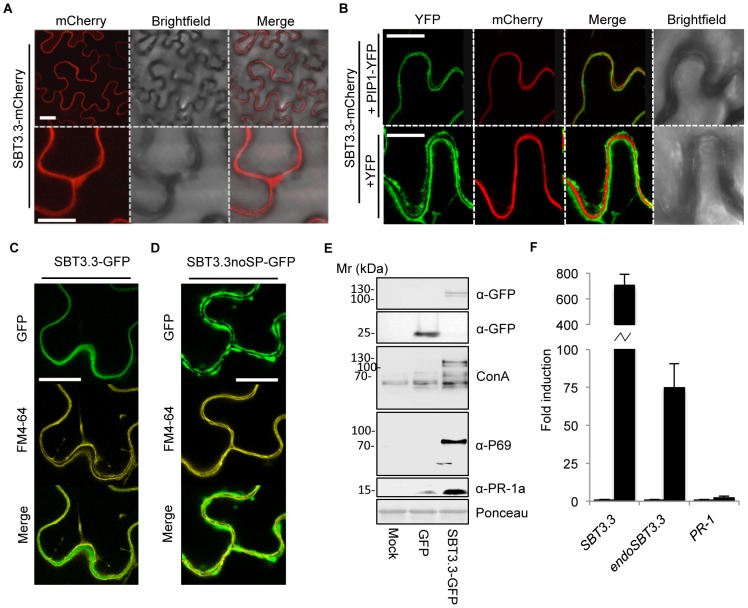
Extracellular localization of SBT3.3-mCherry in N.
benthamiana leaves by confocal microscopy.(A) Expression of SBT3.3-mCherry (50 hpi) results in a uniform extracellular fluorescence. (B) Co-expression of SBT3.3-mCherry with the plasma membrane marker PIP-YFP (upper panel) and with free cytosolic YFP (lower panel). (C) Co-localization of SBT3.3-GFP with the plasma membrane fluorescent marker FM4-64. (D) Co-localization of SBT3.3noSP-GFP with the plasma membrane fluorescent marker FM4-64. Scale bars are 10 µm (A-upper panel), 40 µn (A-lower panel, B, C and D panels). (E) Western blots of total protein extracts from N. benthamiana leaves transitorily overexpressing GFP alone or a SBT3.3-GFP fusion proteins revealed with either concanavalin A, or with anti-GFP, anti-P69 and anti-PR-1a antibodies. Total protein extracts from empty A. tumefaciens agroinfiltrated N. benthamiana leaves (mock) were used as controls. (F) Overexpression of SBT3.3 under the control of a 35S promoter in stable transgenic Arabidopsis plants triggers activation of the endogenous SBT3.3 gene. Accumulation levels of the 35S driven SBT3.3 transcripts (SBT3.3), the endogenous SBT3.3 transcripts (endoSBT3.3) and PR-1 transcripts were measured comparatively in healthy Col-0 plants (left bars) and in a transgenic 35S::SBT3.3OEX line (right black bars). Data represent the mean ± SD; n = 3 biological replicates and gene expression given as in Fig. 1.